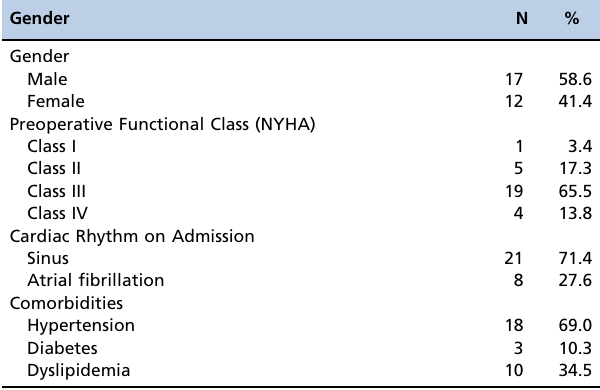
Table 1 - Patients Characteristics.